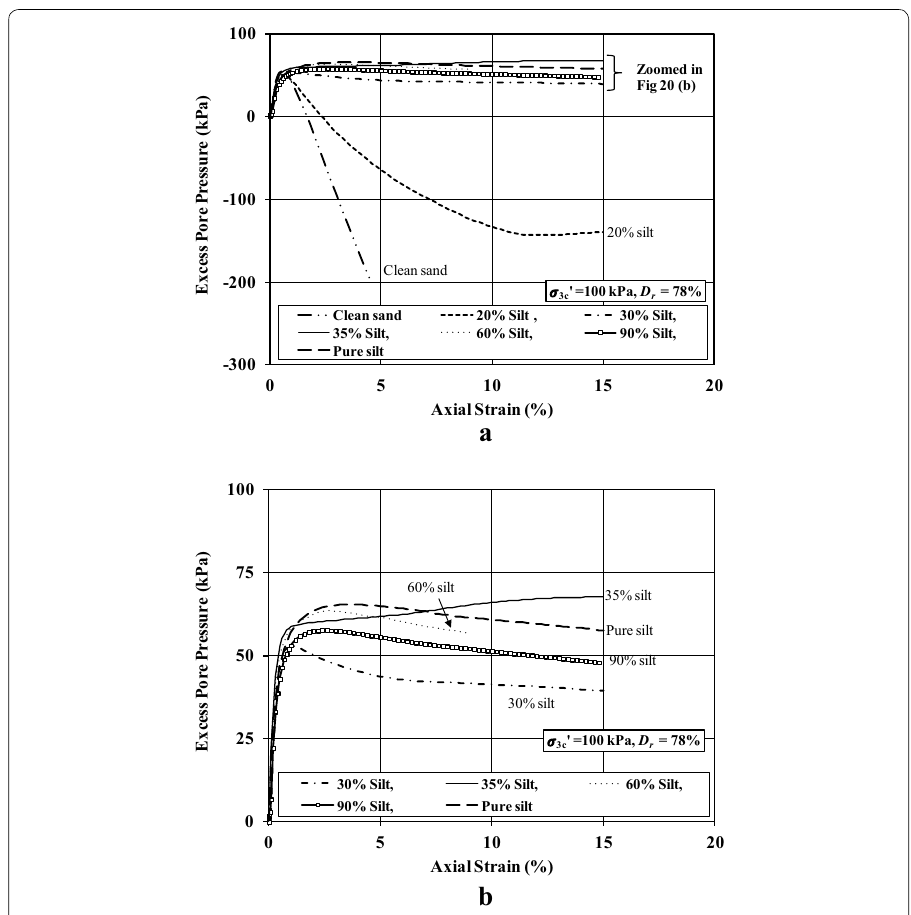
Fig. 20 Excess pore pressure versus strain curve at 78% relative density; a silt content 0–100% and b silt content 30–100%